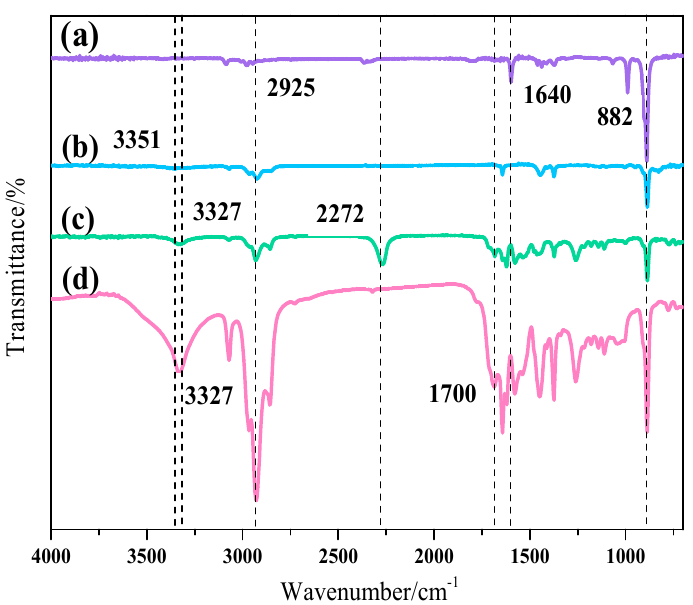
Figure 4. Fourier-transform infrared (FTIR) spectra of ( a ) isoprene, ( b ) PI-OH, ( c ) PI-NCO, and ( d ) PI-UPy.